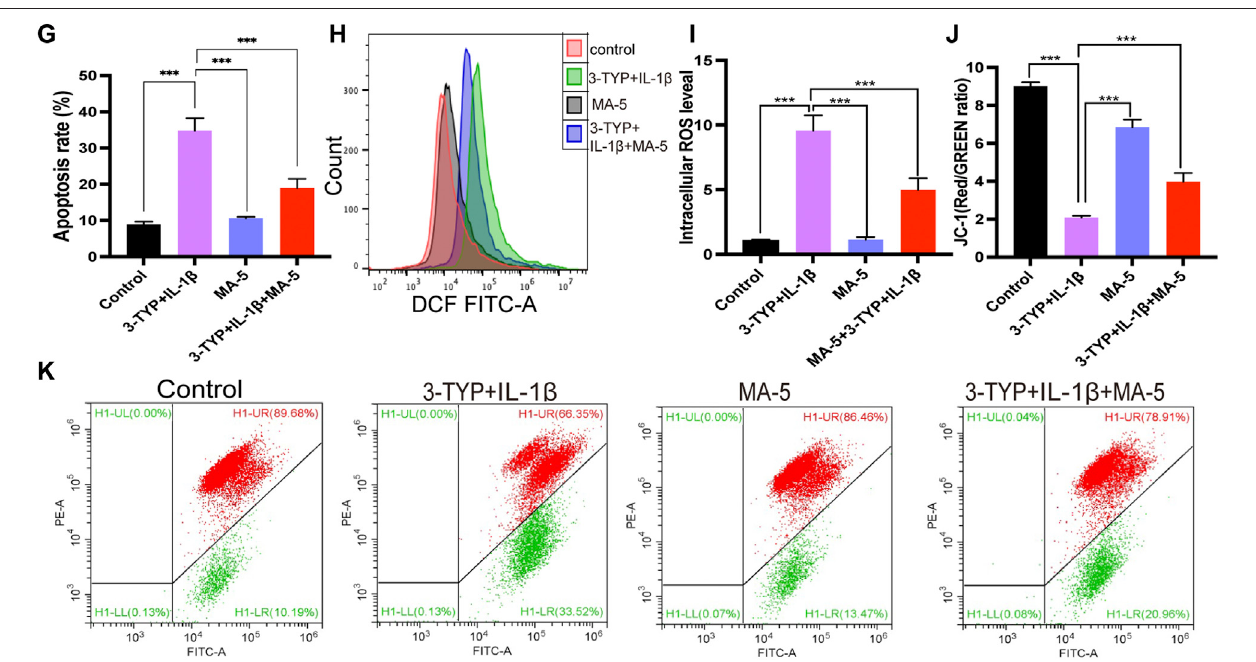
FIGURE5| MA-5preventstheinhibitoryeffectsof3-TYPontheSIRT3/ParkinaxisinOAcells. (A – C) ExpressionofSIRT3andParkinweredetectedusingwestern blotting. (D) Difference in Parkin fl uorescent signal in mitochondria were assessed using confocal microscopy. (E) Differences in LC3B expression were detected via immuno fl uorescence. (F – K) Cellapoptosis,ROS,andmembranepotentialweredetectedvia fl owcytometry.Alldataarepresentedasmean±standarddeviation.*** p < 0.001, ** p < 0.01, and * p < 0.05 represent differences between groups, as determined using a one-way analysis of